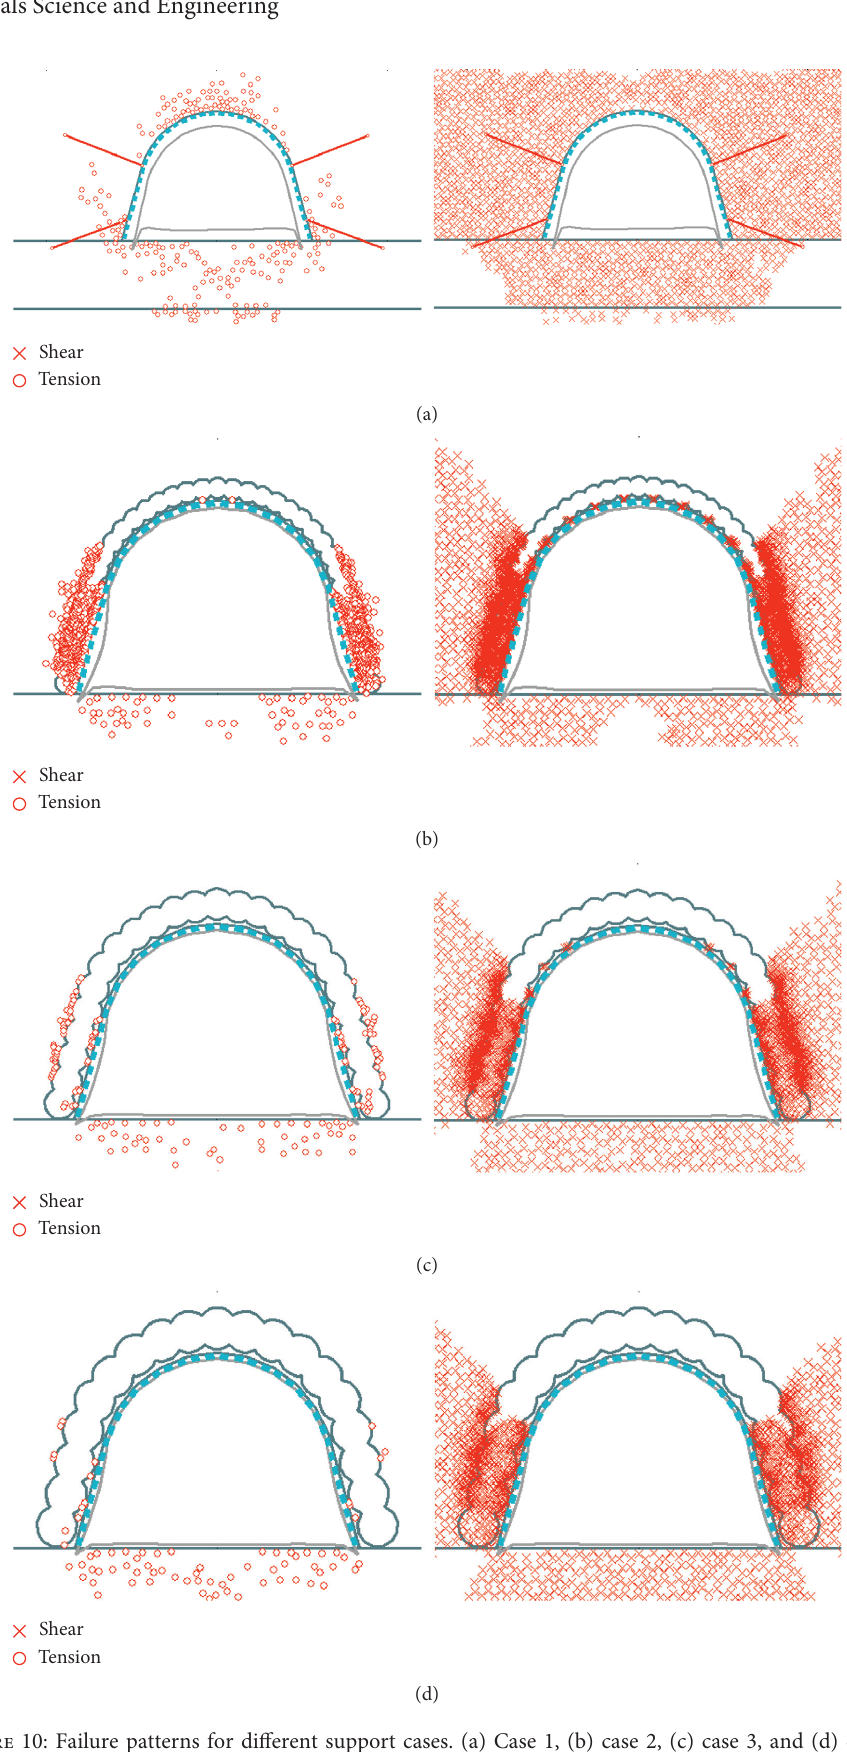
Figure 10: Failure patterns for different support cases. (a) Case 1, (b) case 2, (c) case 3, and (d) case